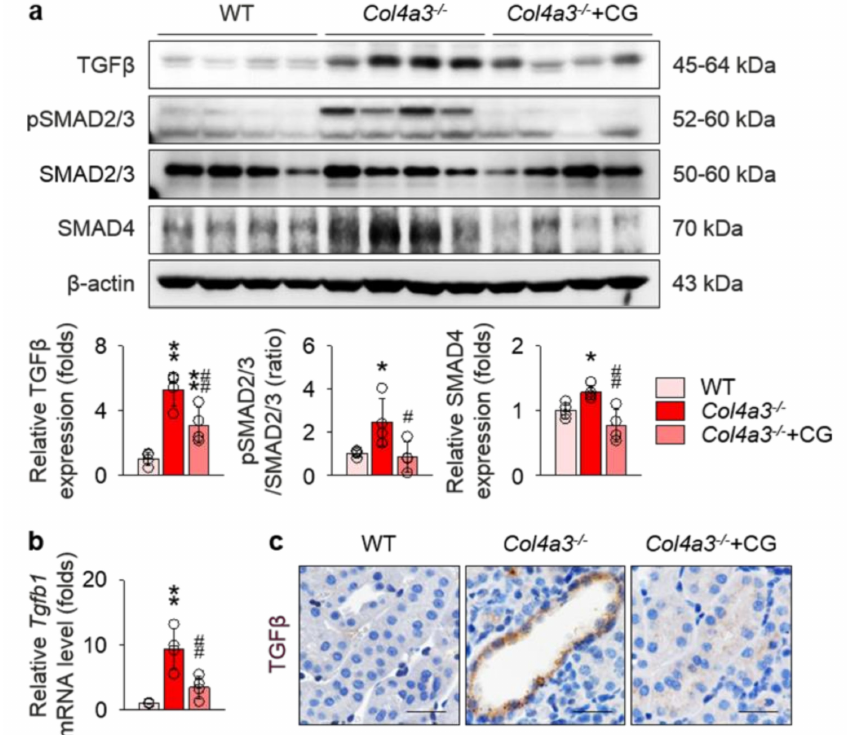
Figure 3. CG attenuated activation of transforming growth factor β (TGF β ) signals in Col4a3 − / −